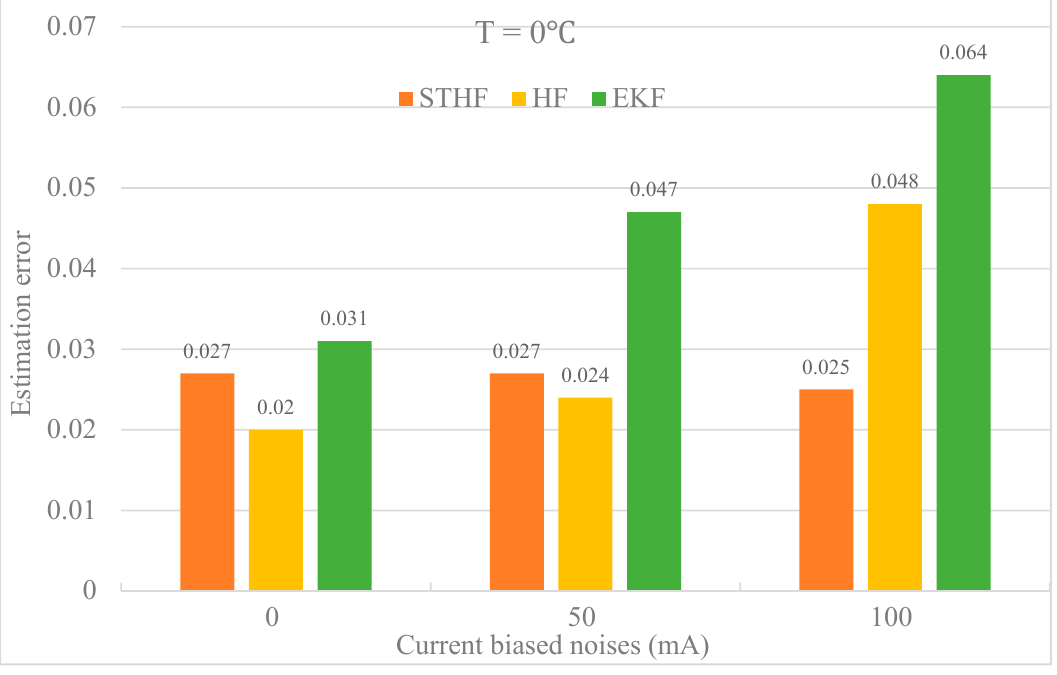
Figure 12. Mean absolute errors of STHF, HF, and EKF at 0 °C.